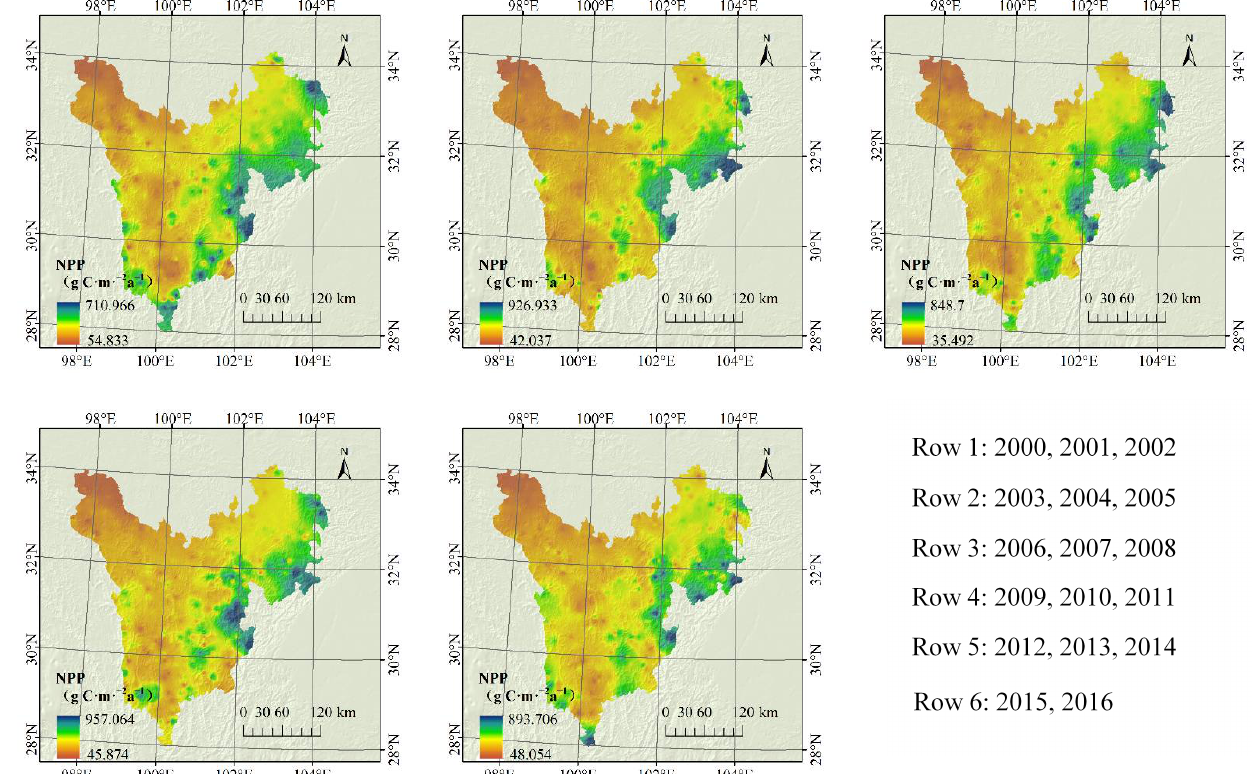
Figure 5. NPP estimation results for 2000−2016.